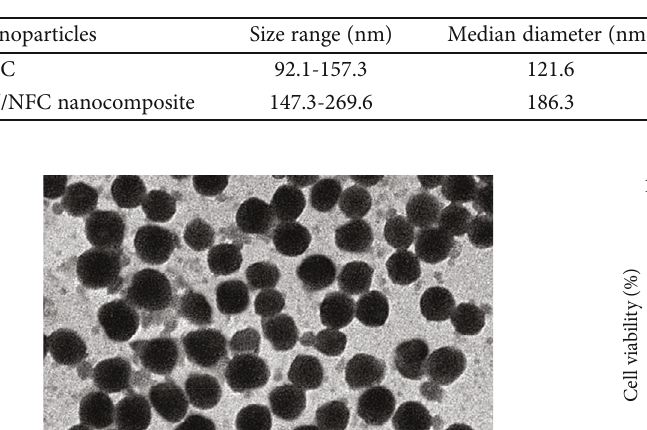
Table 1: Characteristic attributes of synthesized nanoparticles from fungal chitosan (NFC) and its nanocomposite with bee venom (BV/NFC).